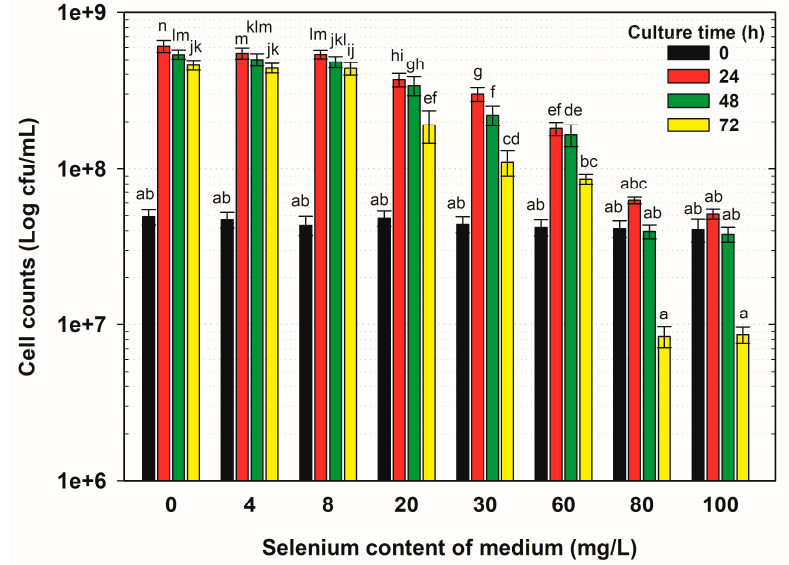
Figure 1. Changes in the number of C. utilis yeast cells (Log cfu/mL) after cultivation in the control (YPD) and in the experimental media enriched with selenium in the form of Na 2 SeO 3 . a − n Means with the same letter did not differ significantly ( p < 0.05).